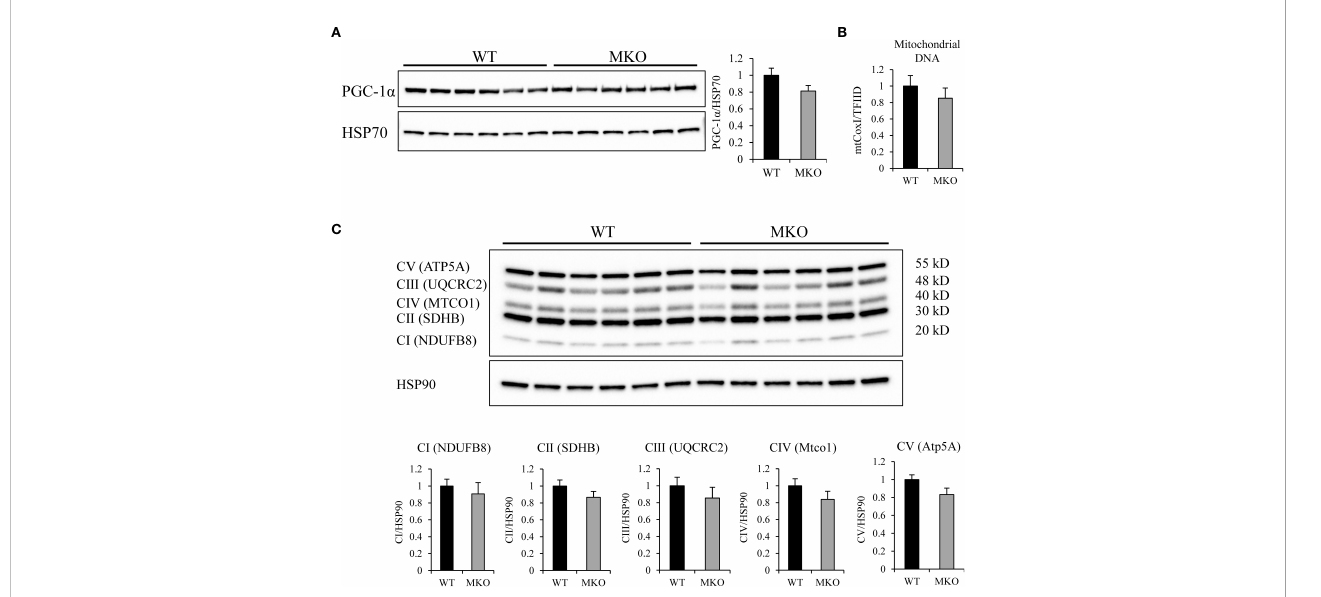
FIGURE 4 Expression of PGC-1 a and ETC complexes and mitochondrial DNA analysis in Arid5b WT and MKO skeletal muscle. (A) Western blot analysis was performed for PGC-1 a expression in GC muscles. HSP70 was included as a loading control. Quantitation of PGC-1 a expression was performed, and data are presented as the means ± SE. (B) To assess mitochondrial content, DNA was isolated from GC muscles. Real-time PCR was performed for the mitochondrial-encoded gene mtCox1 and the nuclear encoded gene TFIID , and mitochondrial content was assessed from the ratio of CoxI to TFIID (n=4). Samples were analyzed in triplicare, and results are expressed as the means ± SE. (C) (top) Western blot analysis was performed for expression of fi ve ETC subunits in GC muscles. HSP90 was included as a loading control. CI: NADH:ubiquinone oxidoreductase subunit B8 (NDUFB8), CII: succinate dehydrogenase complex iron sulfur subunit B (SDHB), CIII: ubiquinol-cytochrome C reductase core protein 2 (UQCRC2), CIV: mitochondrially encoded cytochrome C oxidase I (MTCO1), CV: ATP synthase, H+ transporting, mitochondrial F1 complex, alpha subunit 1 (ATP5A1). (bottom) Quantitation of each subunit was performed, and data are presented as the means ± SE.